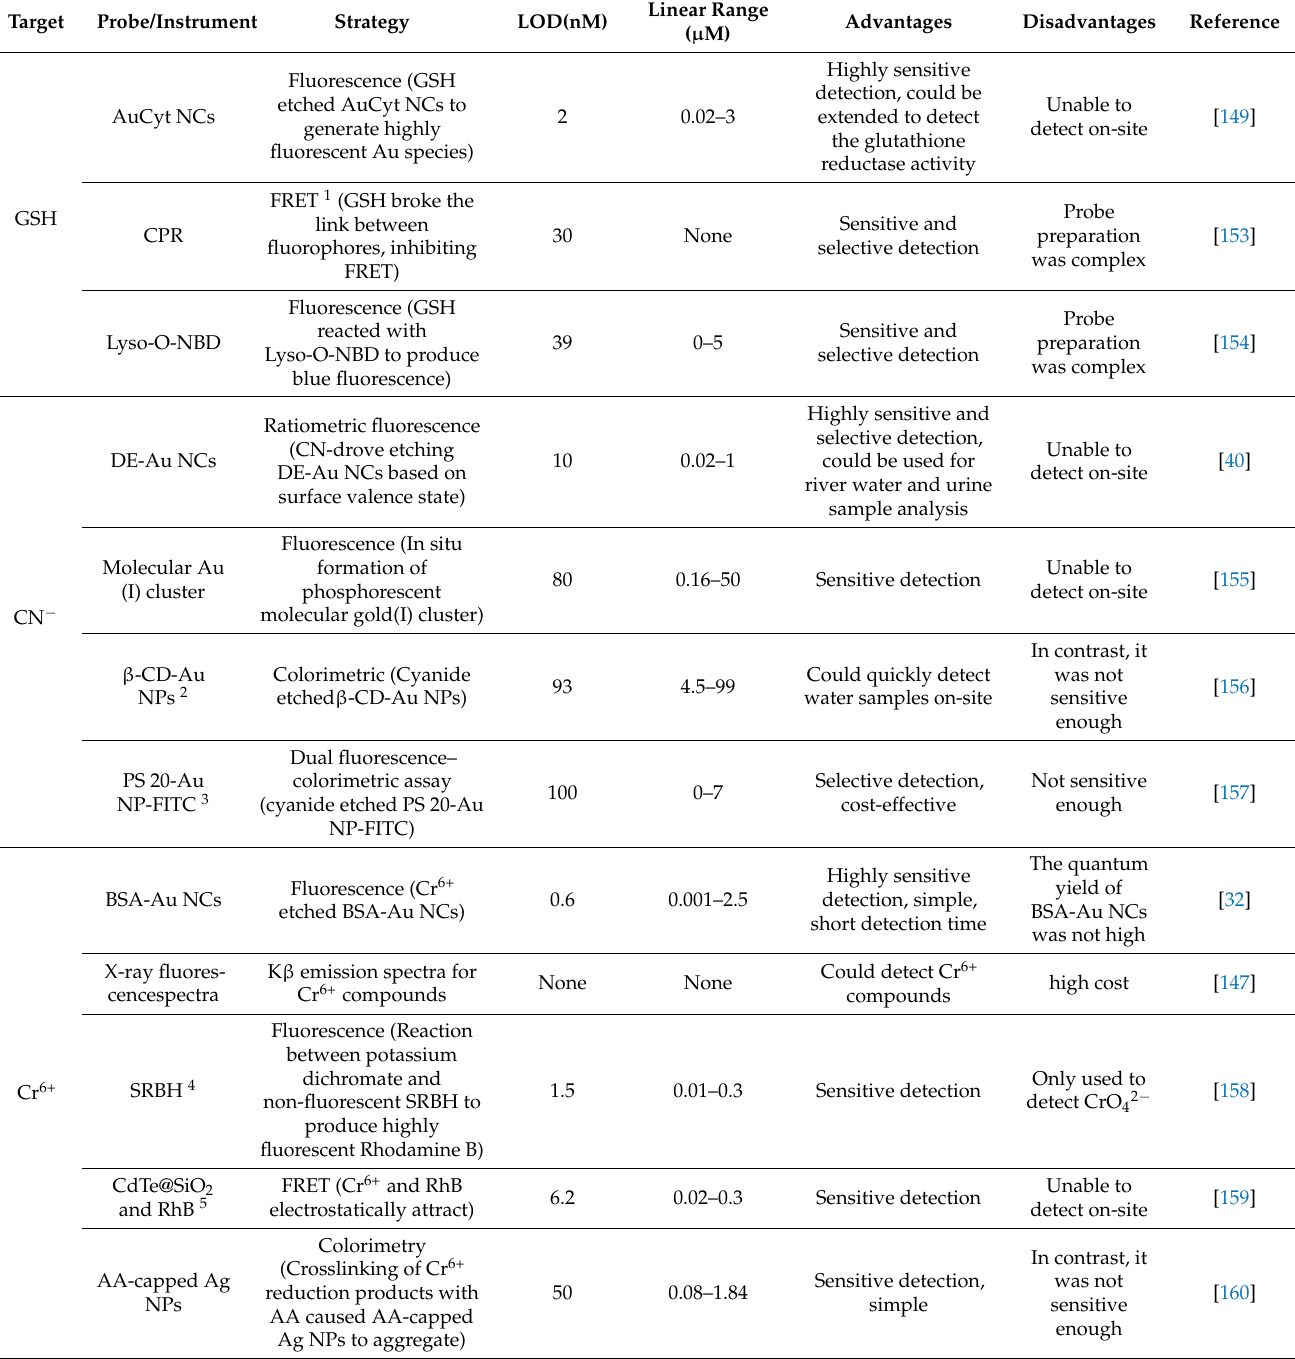
Table 1. Comparison of luminescence sensors based on the etching of coinage metal nanoclusters and other detection